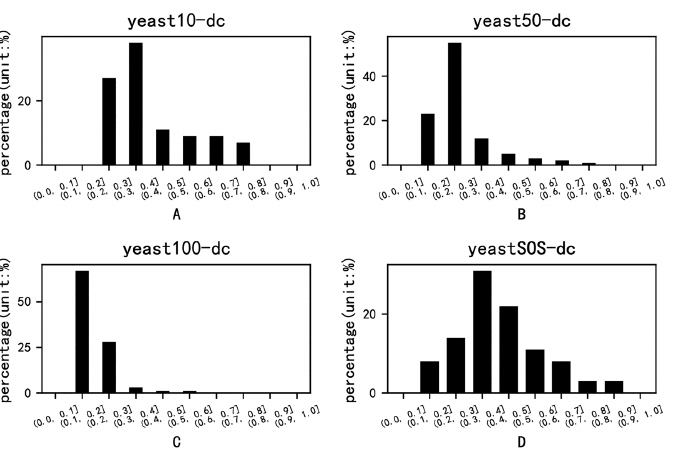
Figure 1. Distribution characteristics of distance correlation statistics.( A ) Distribution of yeast 10- distance correlation characteristics. ( B ) Distribution of yeast 50-distance correlation characteristics. ( C ) Distribution of yeast 100-distance correlation characteristics. ( D ) Distribution of distance-related features in the sos